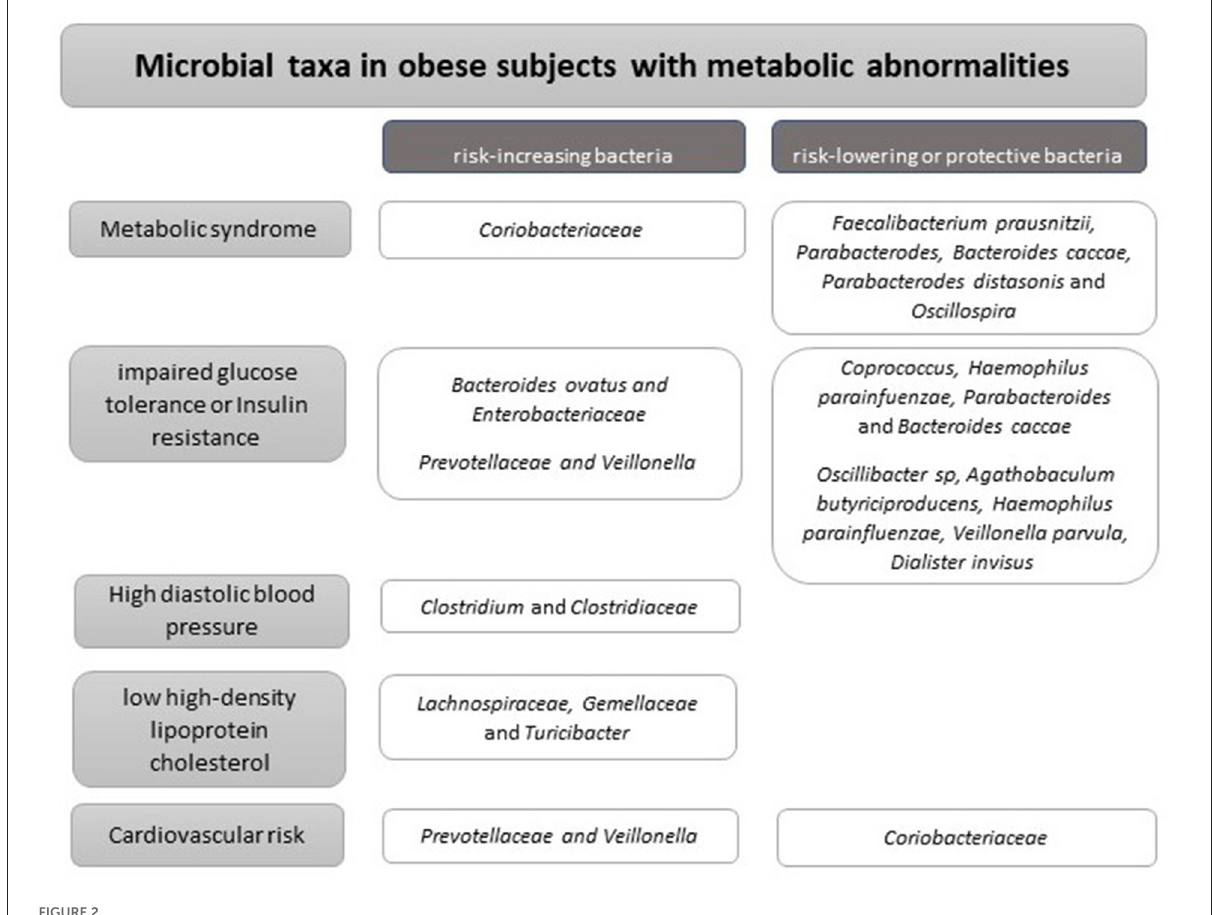
FIGURE2 Microbial taxa in obese subjects with metabolic